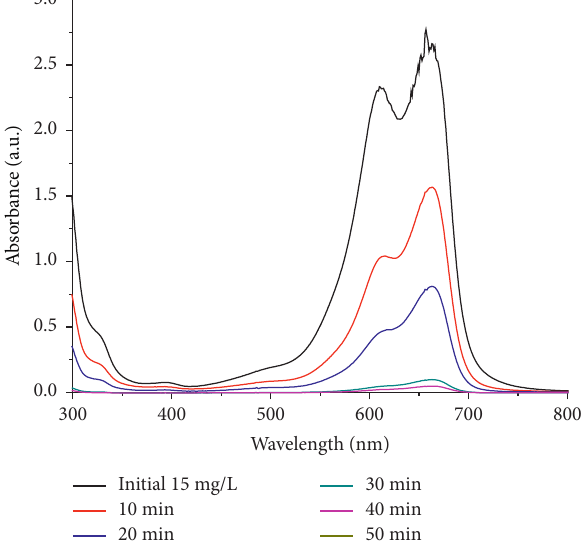
Figure 6: The cyclic voltammetry of the bare 316L stainless steel (blue curve) and the 316L/SnO containing MB 15mg/L (with 2 g/L Na 2 SO 4 ).